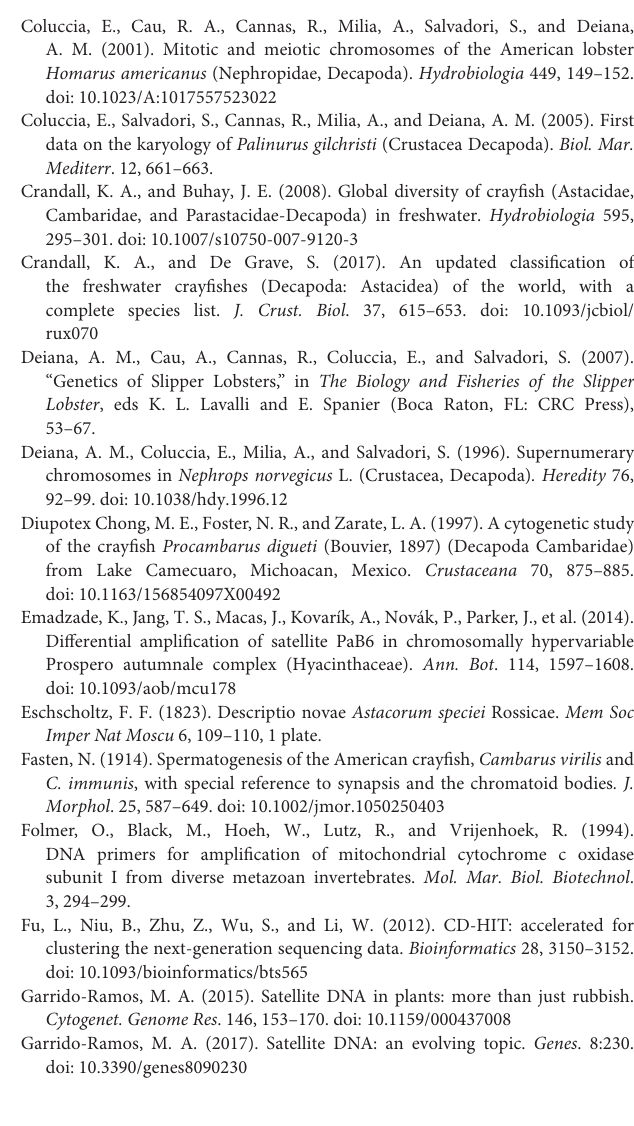
Supplementary Figure 2 | Median-joining network of the COI barcode region haplotypes. Haplotype from the lake Maksimir is marked with an arrow. Haplotype size reflects relative frequency. Each branch represents one mutational step, unless otherwise noted (numbers in red above branches). Black circles represent missing intermediate haplotypes. Different colored circles denote the share of distinct haplotypes within countries (legend is shown in the upper-left corner). Supplementary Figure 3 | An idiogram of P. leptodactylus chromosomes with marked localization of 45S rDNA and DAPI positive AT-rich heterochromatin bands This idiogram was generated based on the FISH information from Figures 1A,B . Supplementary Figure 4 | The graph layout corresponding to read clusters of (A) PlSAT1-21, (B) PlSAT3-411, (C) PlSAT6-70, (D) PlSAT7-134, and (E) PlSAT14-79. The percentage indicates the genome proportion of each cluster. Supplementary Figure 5 | Sequence logos showing the level of sequence divergence. Supplementary Figure 6 | Dot plot analysis of (A) PlSAT1-21, (B) PlSAT3-411, (C) PlSAT6-70, (D) PlSAT7-134, and (E) PlSAT14-79 obtained in TAREAN analysis of P. leptodactylus